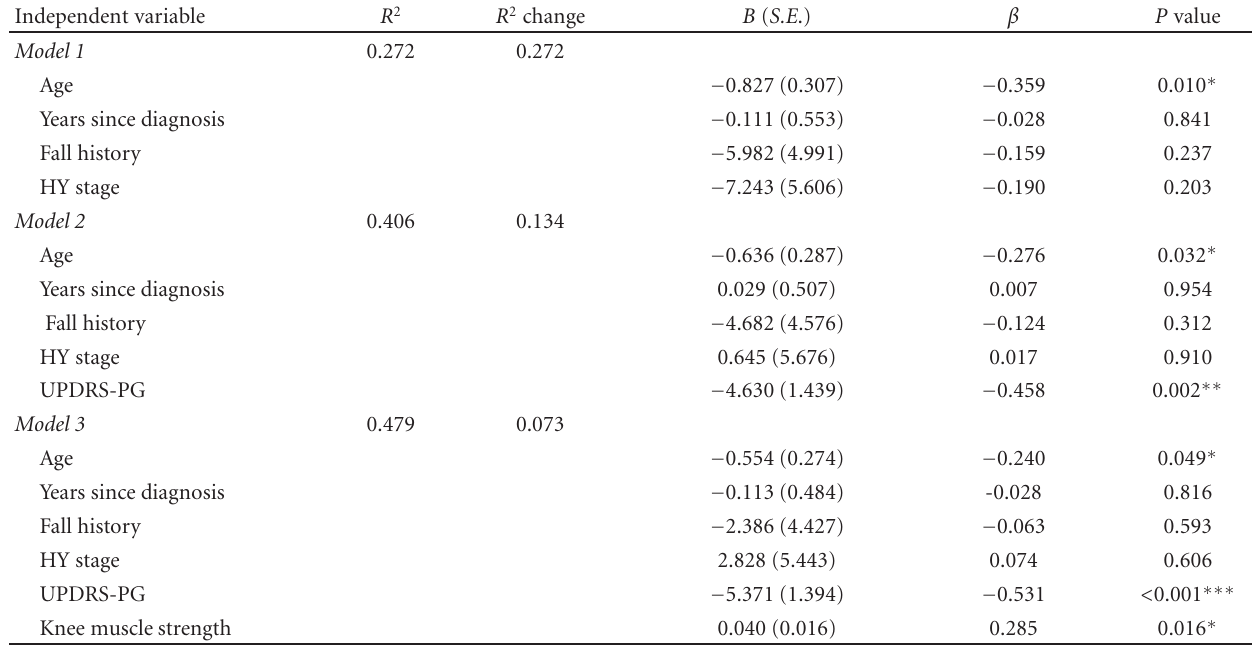
Table 2: Multiple regression analysis for predicting the ABC